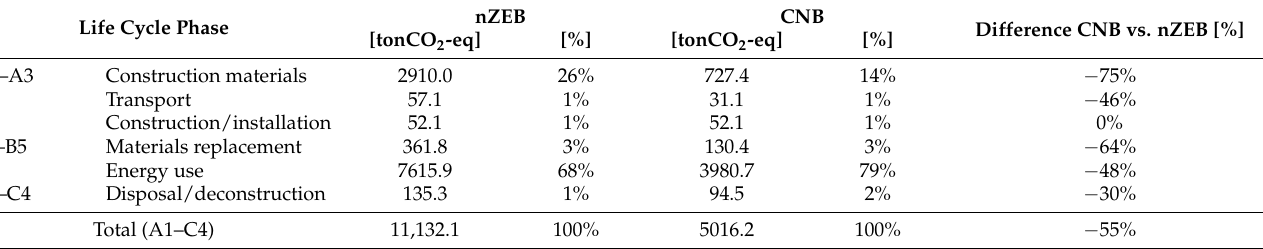
Table 6. Building carbon footprint for the analyzed scenarios (CNB vs. nZEB) in the whole lifecycle. Life Cycle